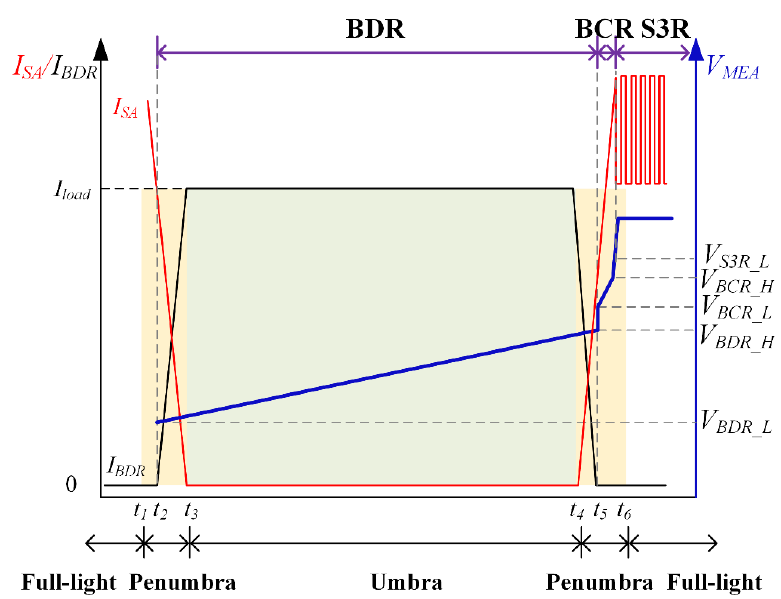
Figure 18. Waveforms of PCU with constant power load during Earth eclipse period.